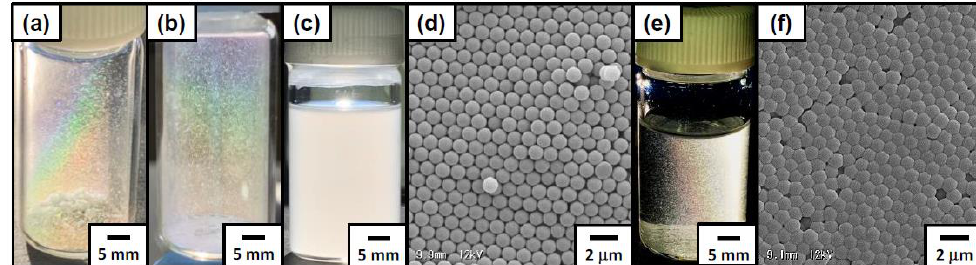
Figure 7. Digital photographs of ACMPA-PS particle-stabilized foam fragments prepared at pH 2.0 viewed under ( a , c , e ) white light and ( b ) sunlight. The fragments were dispersed in ethanol ( c ) before and ( e ) after annealing with toluene vapor for 15 min. SEM images of foam fragments ( d ) before and ( f ) after the annealing with toluene vapor.